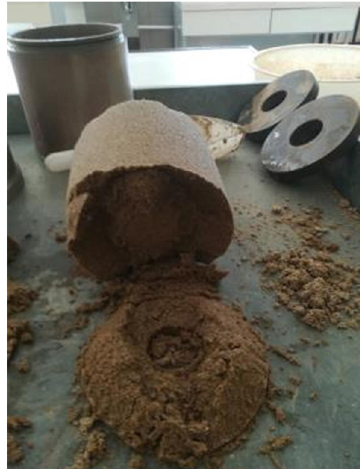
Figure 3. The view of the soil sample after the CBR test